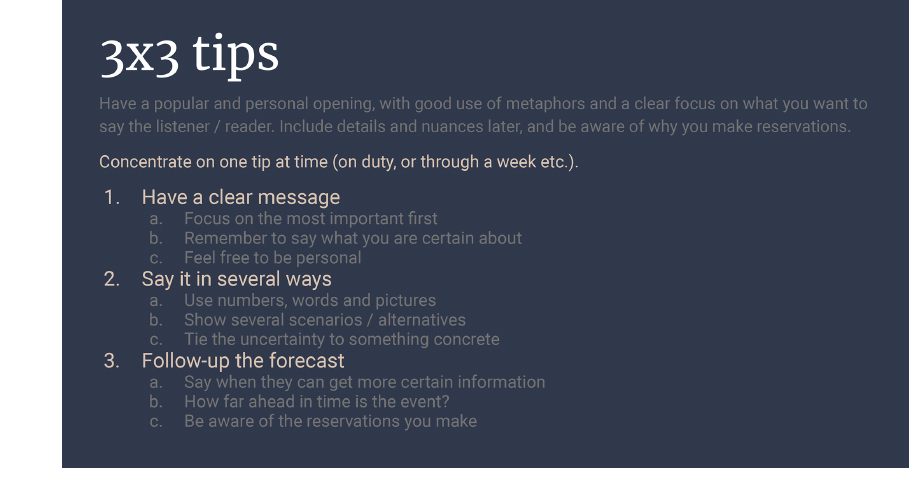
Figure 6. 3 × 3 tips on communication of